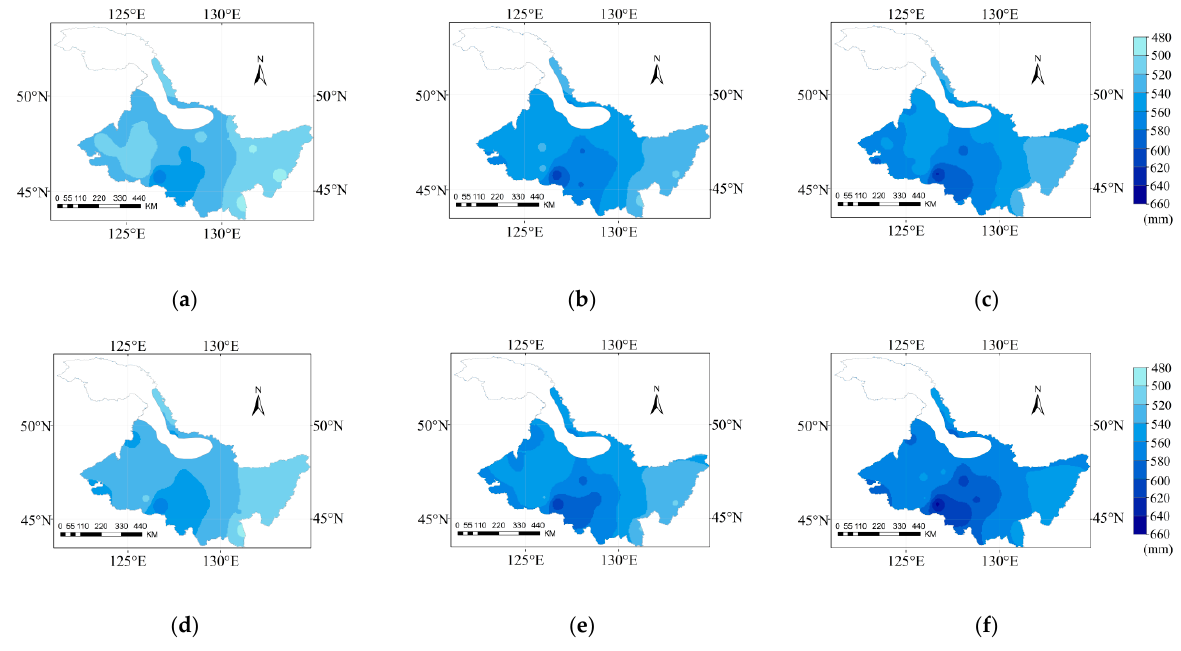
Figure 4. Spatial distribution of reference crop evapotranspiration ( ET 0 ) during the ( a ) 2030s, ( b ) 2050s, and ( c ) 2070s under RCP4.5, and during the ( d ) 2030s, ( e ) 2050s, and ( f ) 2070s under RCP8.5 during the soybean growth period.